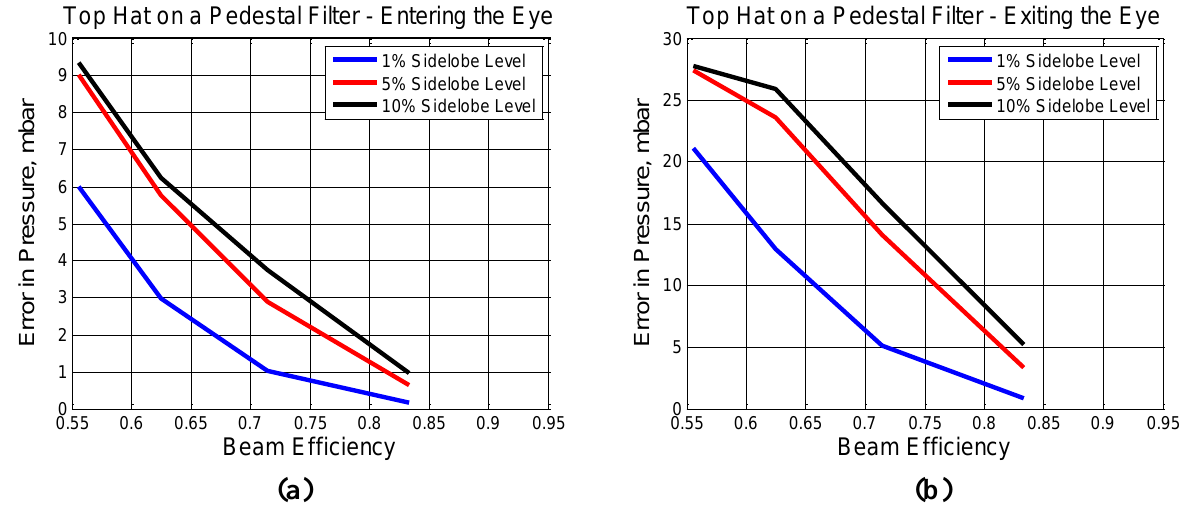
Figure 5. Error in the pressure depression estimation as a function of antenna beam efficiency for (a) entering the eye and (b) exiting the eye region.